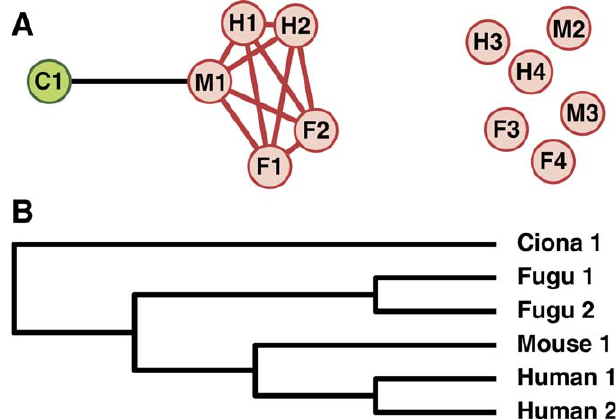
Figure 2. Overview of the Building of a Gene Cluster and Phylogenetic Tree Shown by a Hypothetical Example (A) Each circle represents a gene, labeled with the source genome according to the first letter of each taxon—C, M, H, and F for Ciona, mouse, human, and fugu, respectively—and further differentiated by numeral. BLASTP was first used to search all vertebrate genes for the one most similar to Ciona’ s C1 gene, in this case the mouse gene M1. Then other genes are recruited to the cluster if they have a higher similarity score to M1 that that between C1 and M1, indicated here by the red lines. The six genes shown on the right side of the diagram have some sequence similarity to those in the cluster, but less than that between C1 and M1, so are not included. Because the vertebrates are more closely related to each other than any is to Ciona, each cluster will include those genes descended from a single gene in the common chordate ancestor, having arisen by either lineage splitting or gene duplication specific to one or more vertebrates. (See Materials and Methods for more details.) (B) Evolutionary tree of the genes in this cluster show separate duplications for fugu and for human. Because the maximum likelihood method does not rely solely on sequence similarity, there is no significance to the mouse gene being most similar to C1. The mouse genome simply contained the most slowly evolving vertebrate gene in this multigene family; this can be from any vertebrate taxon with approximately equal likelihood. DOI: 10.1371/journal.pbio.0030314.g002